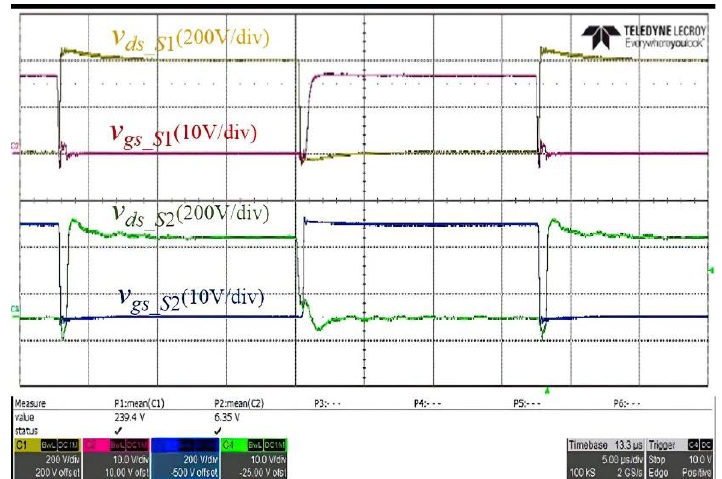
Figure 14. Experimental waveforms of the gate-to-source and drain-to-source voltage waveforms for S 1 and S 2.